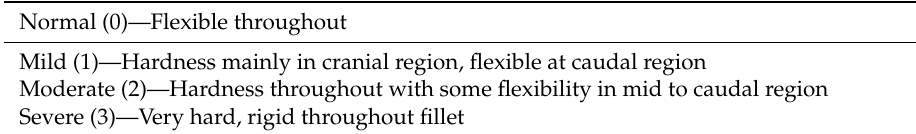
Table 2. Guidelines for woody breast scoring.